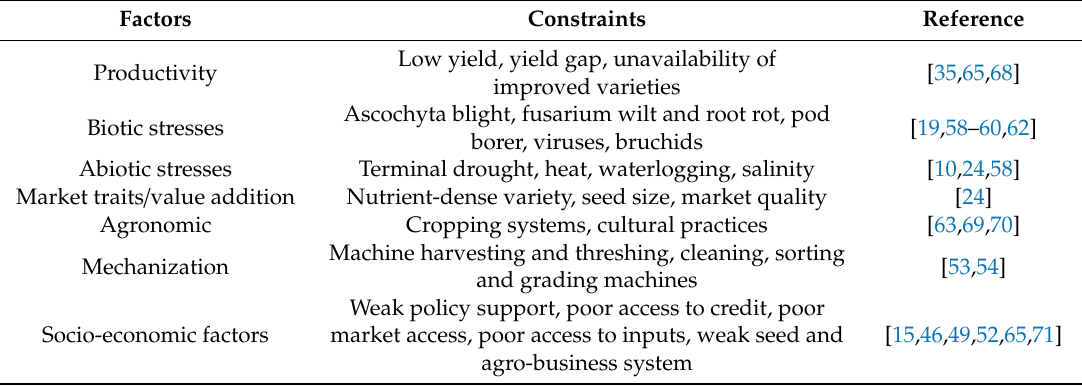
Table 3. Major constraints and research gaps of chickpea in